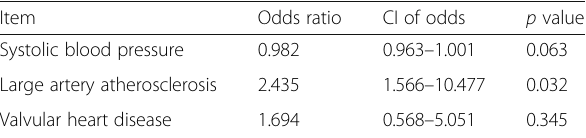
Table 4 Multivariate logistic regression analysis of the possible risk factors for early